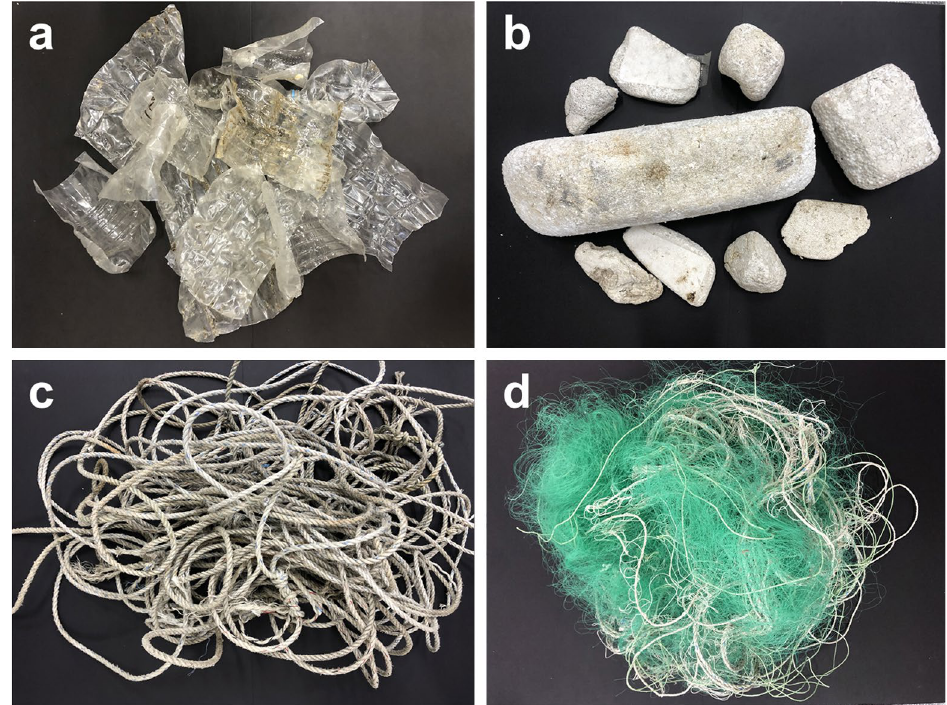
Figure 9. Photograph of classified wastes such as ( a ) plastic bottles, ( b ) buoys, ( c ) rope, and ( d ) fishing nets for LTP